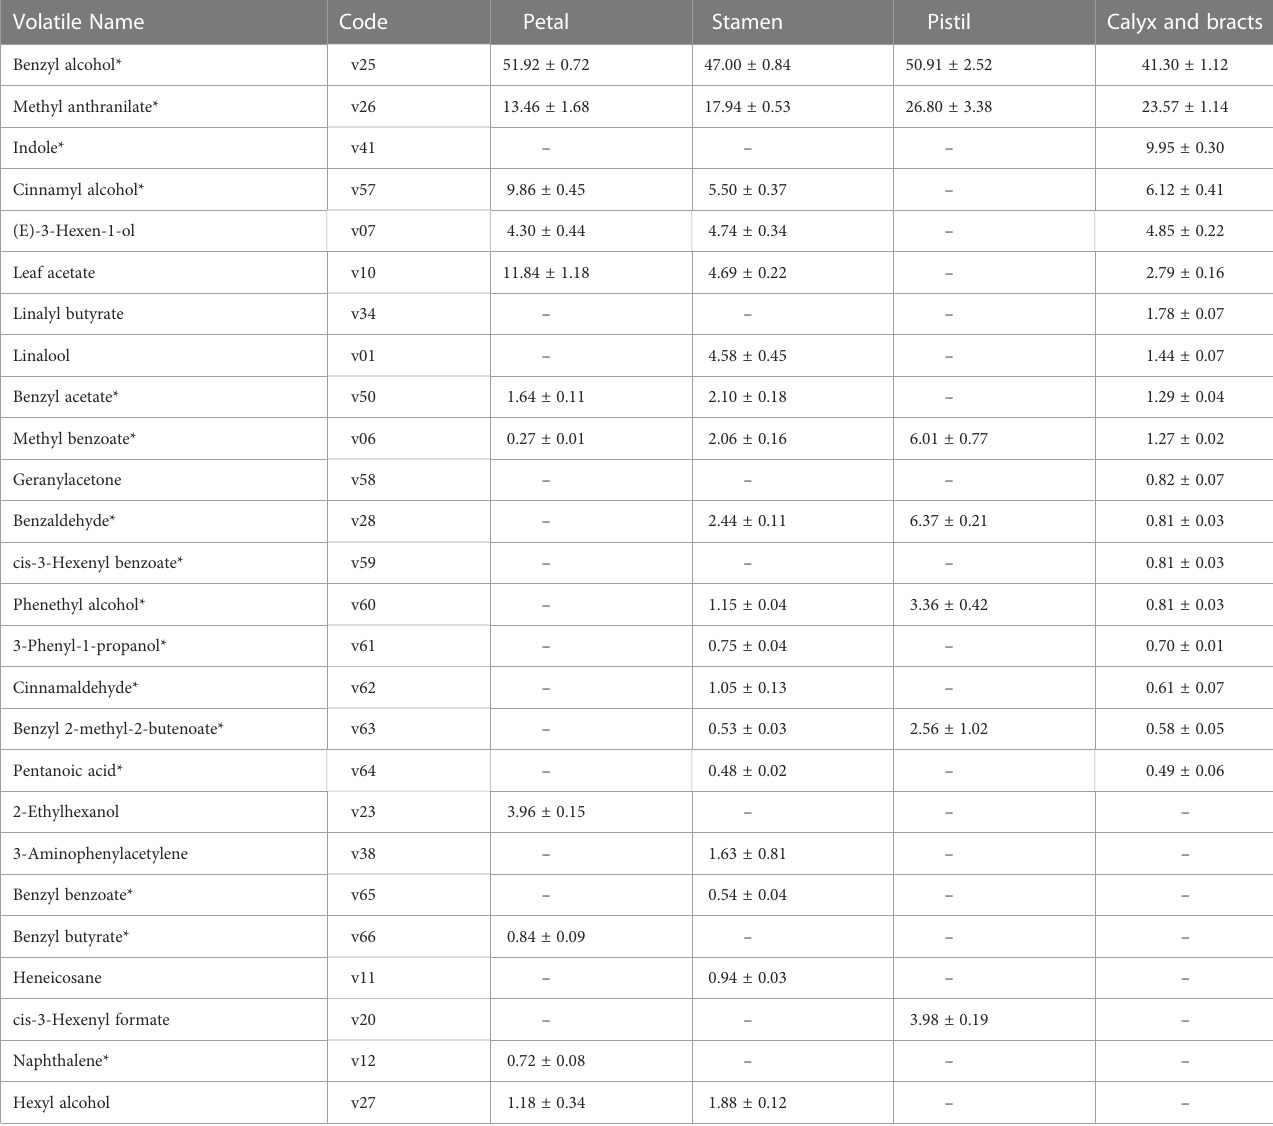
TABLE 3 Relative contents of volatiles in different fl oral organs